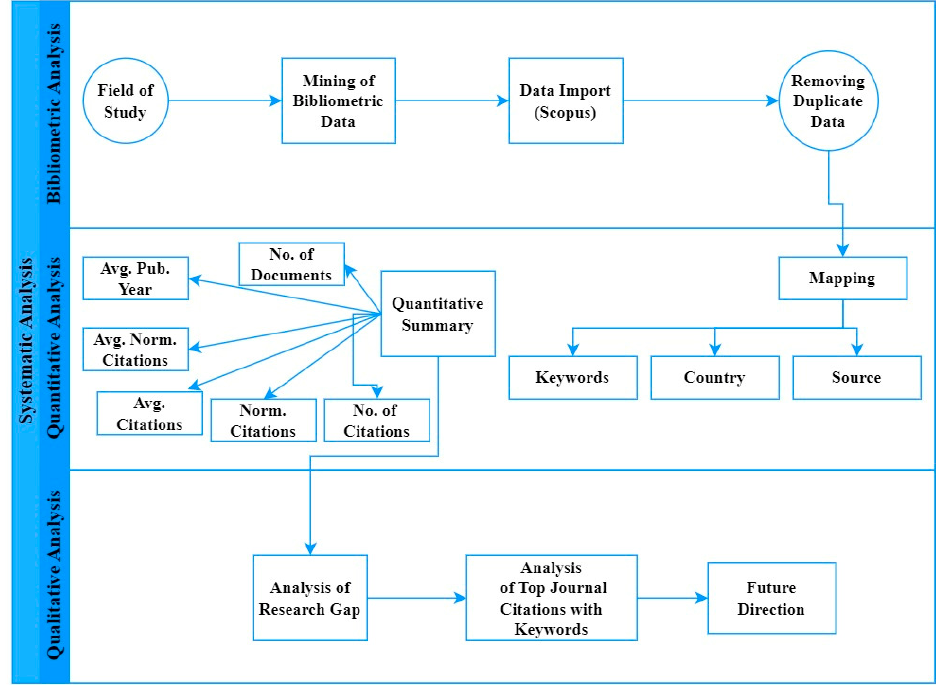
Figure 3. Methodology of